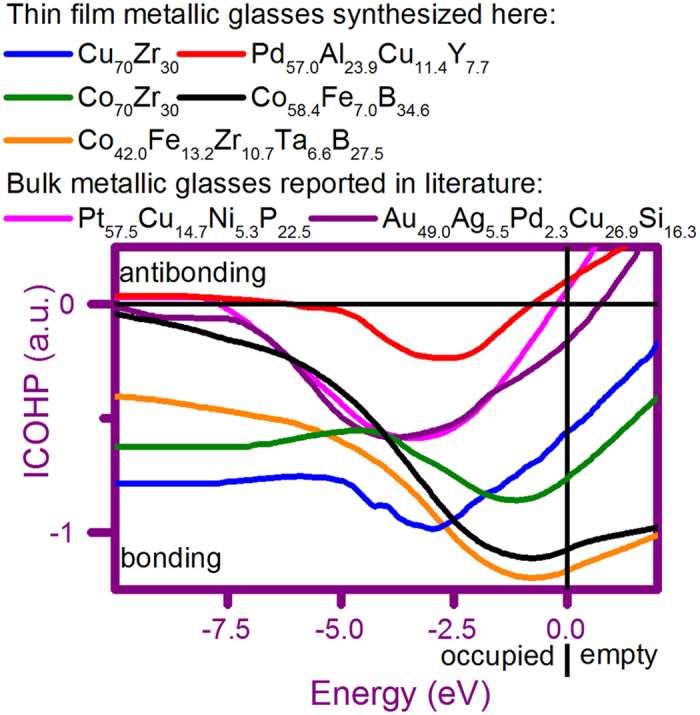
Bonding interactions for all systems evaluated.The density of states analysis is consistent with the bonding analysis in the form of the integrated crystal orbital Hamilton population (ICOHP). For the Pt57.5Cu14.7Ni5.3P22.53 and Au49Ag5.5Pd2.3Cu26.9Si16.318 bulk metallic glasses synthesised and tested in the literature, we have completed mechanical property reports along with electronic structure information.